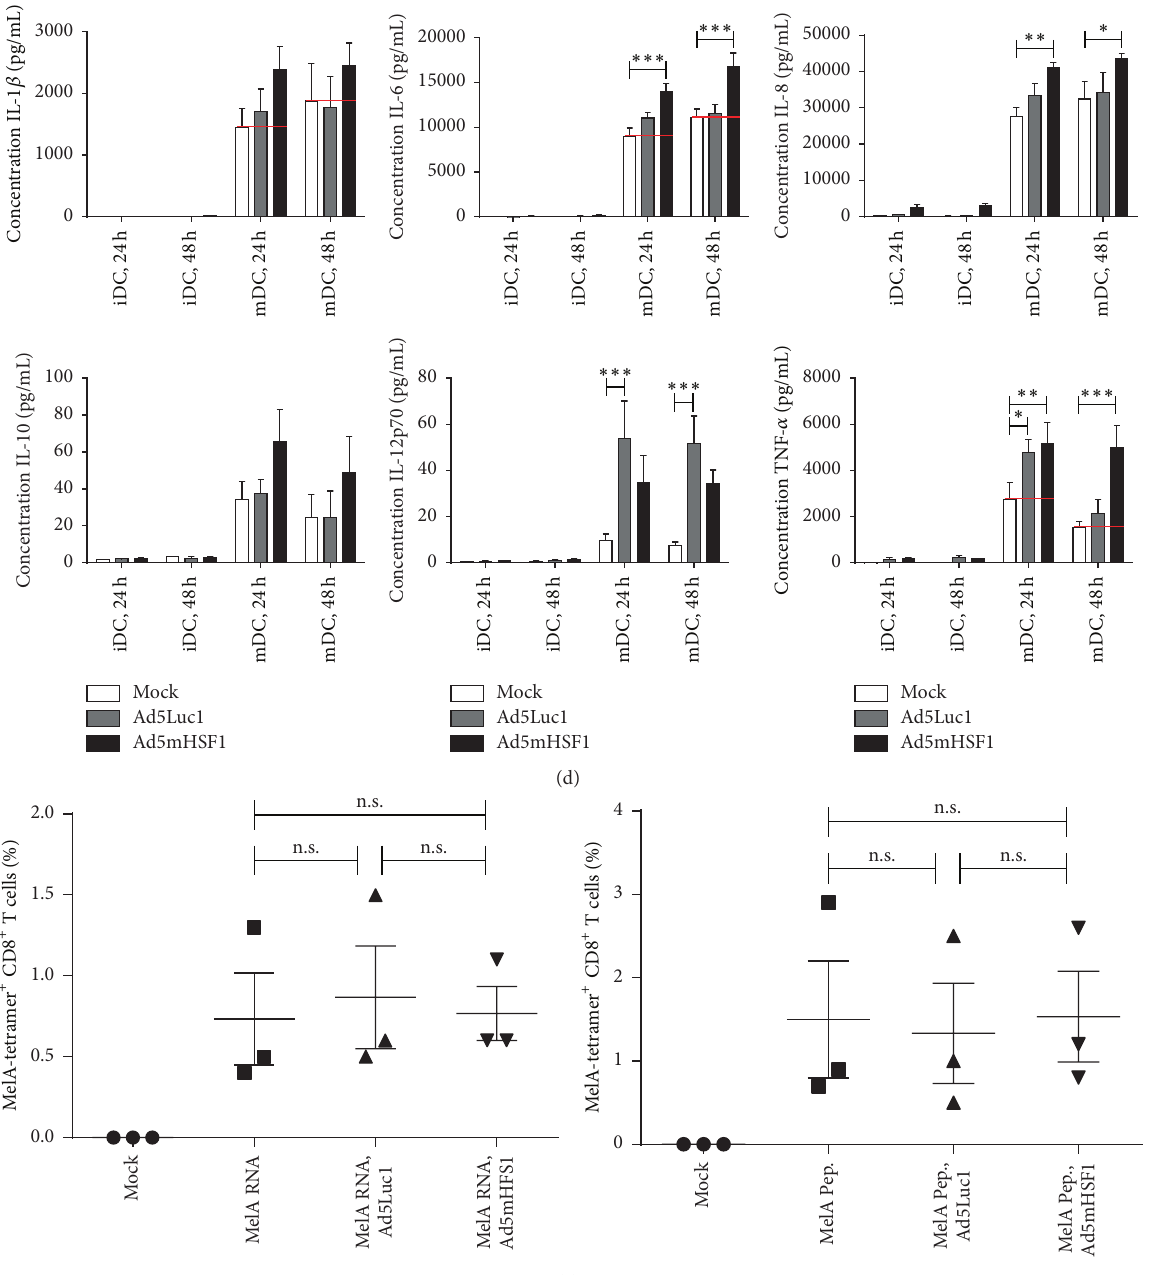
Figure 4: Overexpression of mHSF1 does not impair the phenotype and function of immature and mature DCs. Immature DCs were transduced with Ad5Luc1 or Ad5mHSF1 at 500 TCID 50 /cell or Mock-treated and were either left immature (“iDC”) or were matured (“mDC”) with a maturation cytokine cocktail (IL-1 𝛽 , IL-6, TNF- 𝛼 , and PGE 2 ). (a) Western Blot analyses of cell lysates harvested 24 h after transduction on HSF1, mHSF1, Hsp40, Hsp70A, Hsp70B 󸀠 , Hsp90, Grp94, and beta-actin protein expression. One representative experiment out of three is shown. (b, c) Flow cytometric analyses of iDCs and mDCs on CD25, CD80, CD83, CD86, HLA-ABC, and HLA-DR (b) as well as PI (c) 24 h and 48 h after transduction. Data are mean ± SEM of four independent experiments with DCs derived from different donors. (d) Cell culture supernatants derived from experiments shown in (b and c) were analyzed by cytometric bead array for the content of IL-1 𝛽 , IL-6, IL-8, IL-10, IL-12p70, and TNF- 𝛼 . The red line in (d) indicates background levels of respective cytokines derived from the cytokines present in the maturation cocktail. Data are mean ± SEM of three independent experiments. (e) Twenty-four hours after adenoviral transduction accompanied by maturation of DCs, cells were either transfected with wild-type MelanA RNA (left panel) or loaded with MelanA analogue peptide (right panel). Antigen-loaded DCs were cocultured with MACS-sorted autologous CD8 + T cells for seven days. Induction of antigen- specific CTLs was determined by HLA-A2-MelanA/iTag MHC class I-tetramer and anti-CD8-PC7 staining using a FC500 cytofluorometer. Data are mean ± SEM of three independent experiments with different donors. (b–e) ∗ 𝑃 < 0.05 , ∗∗ 𝑃 < 0.01 , ∗∗∗ 𝑃 < 0.001 , and n.s.: not significant ( 𝑃 > 0.05 ); bars without annotation are not significant ( 𝑃 > 0.05 ), one-way, (e) or two-way ANOVA (b–d) with Bonferroni’s Multiple Comparison post hoc